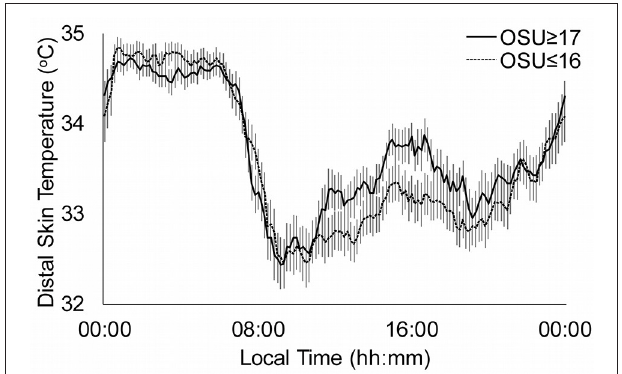
FIGURE 2 | Distal skin temperature mean daily patterns for substance use disorders according to the age of Onset of Substance Use (OSU). Continuous line represents OSU ≥ 17 ( n = 58) and dotted line OSU ≤ 16 ( n = 56). All data are expressed as mean ± standard error of the mean.